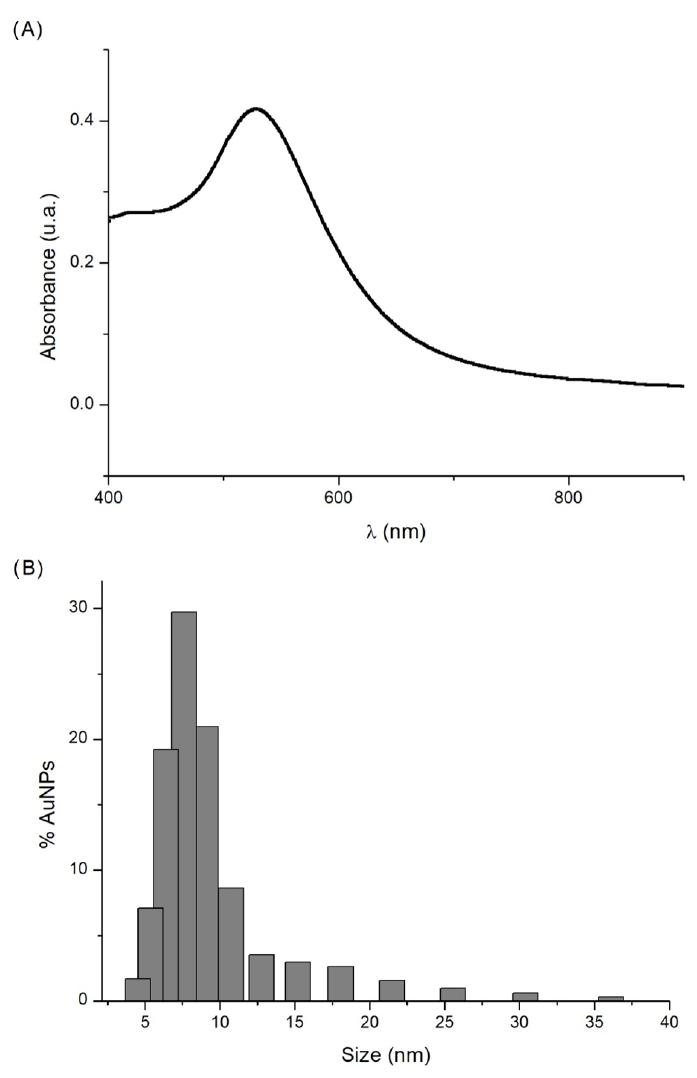
Figure 1. ( A ) UV-vis absorption spectrum for AuNPs aqueous solution and ( B ) size distribution histogram of AuNPs recorded by DLS technique.